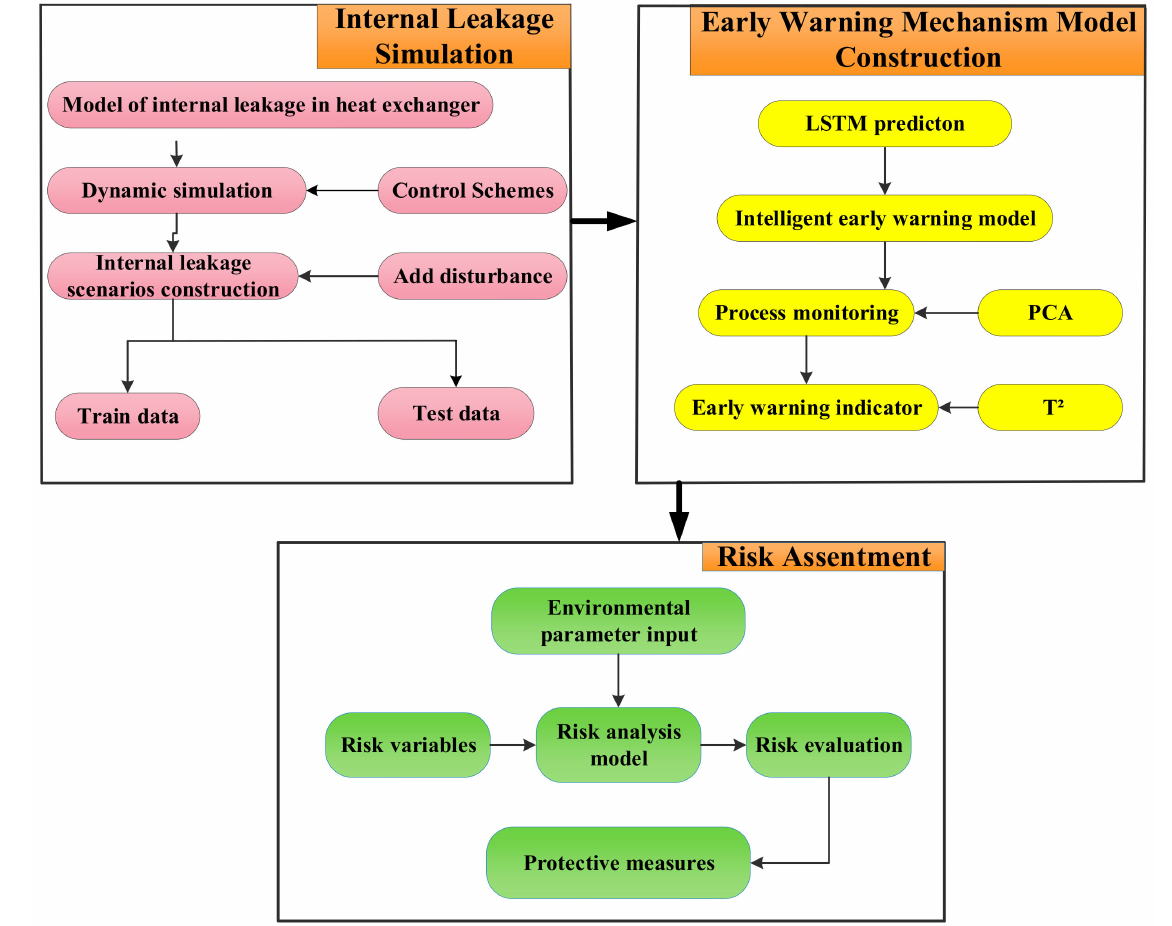
Figure 3. The framework of dynamic simulations (DYN)-early worning (EW)-quantitative risk assessment (QRA) method.